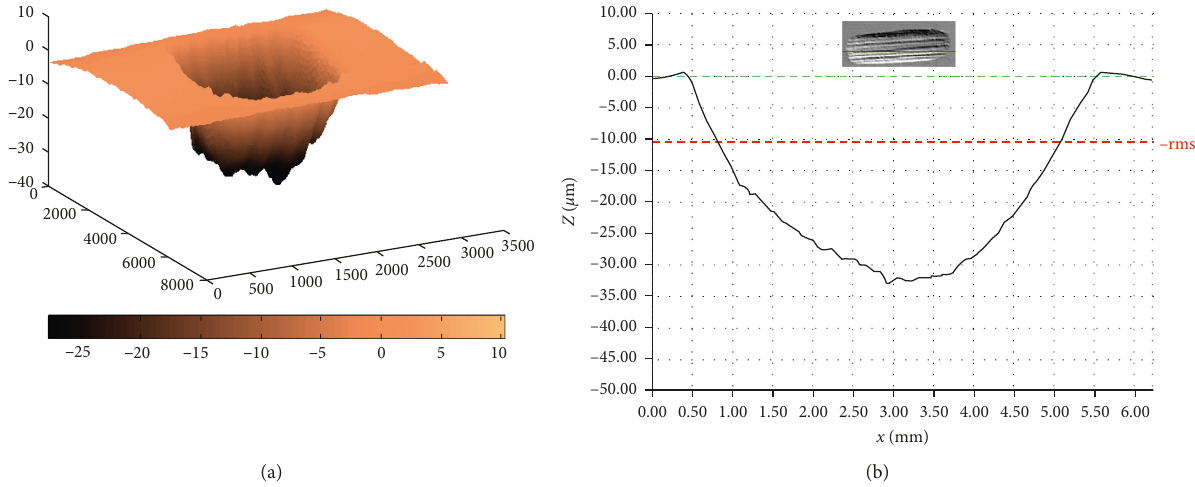
Figure 19: Three-dimensional image of the disk track of steel 3 tested at 200 ° C (a). The maximum profile depth (32 µ m)